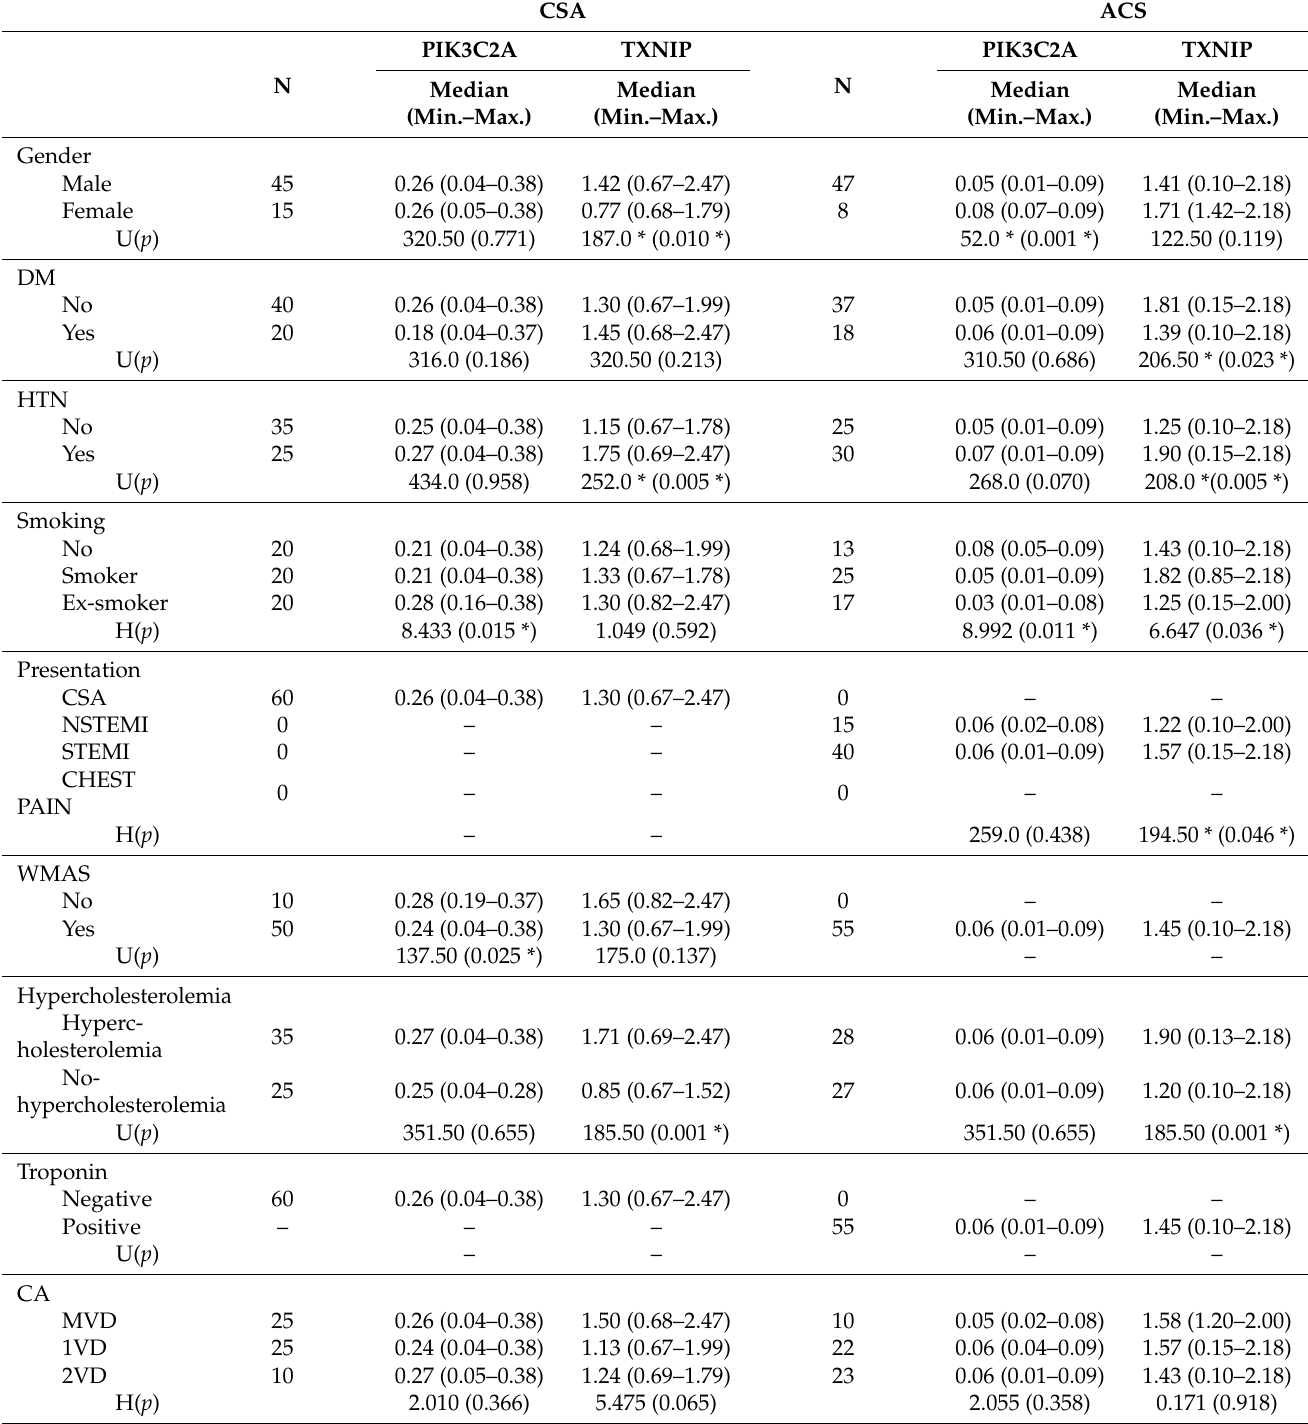
Table 3. Relation between mRNA (PIK3C2A, TXNIP) gene expression level and different parameters in CSA and ACS